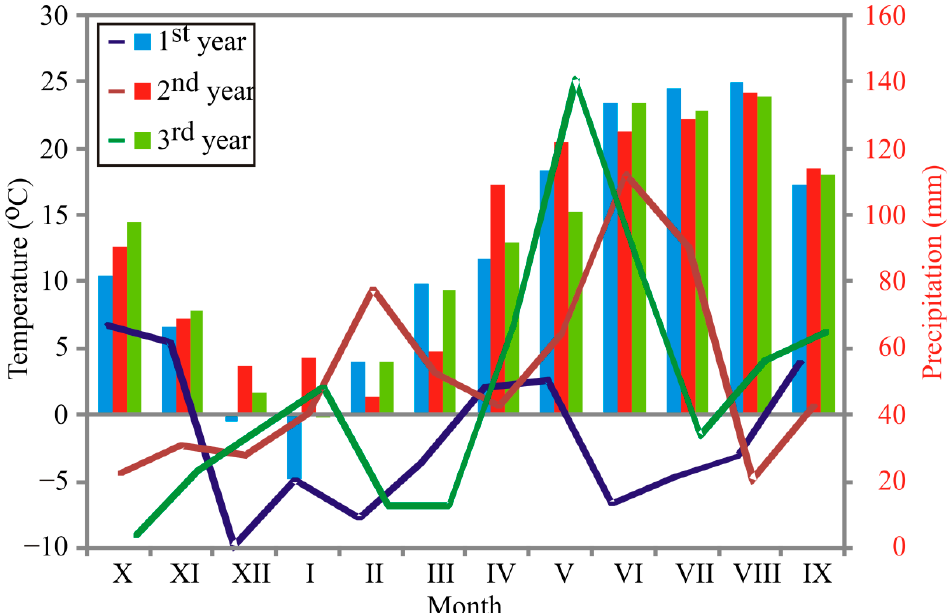
Figure 1. Weather condition during 1st (2016/2017), 2nd (2017/2018) and 3rd (2018/2019) growing seasons. Temperatureswere presented by darker coloured lines, while temperatures were shown by histograms, coloured with pale colours.